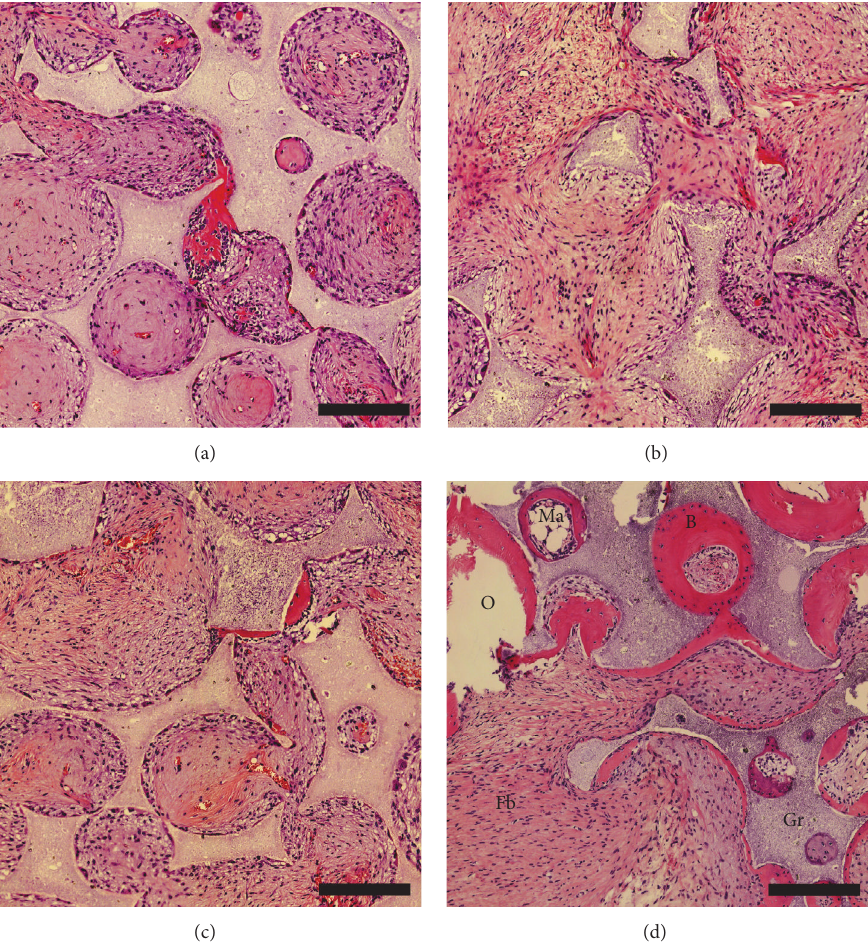
Figure 3: Representative images from A-CEAC1 (a), A-CEAC2 (b), A-CEAC3 (c), and BM-CEAC (d) groups. B: bone; Gr: residual granules; Fb: fibrous tissue; Ma: bone marrow; O: other. Scalebar: 250 𝜇 m.